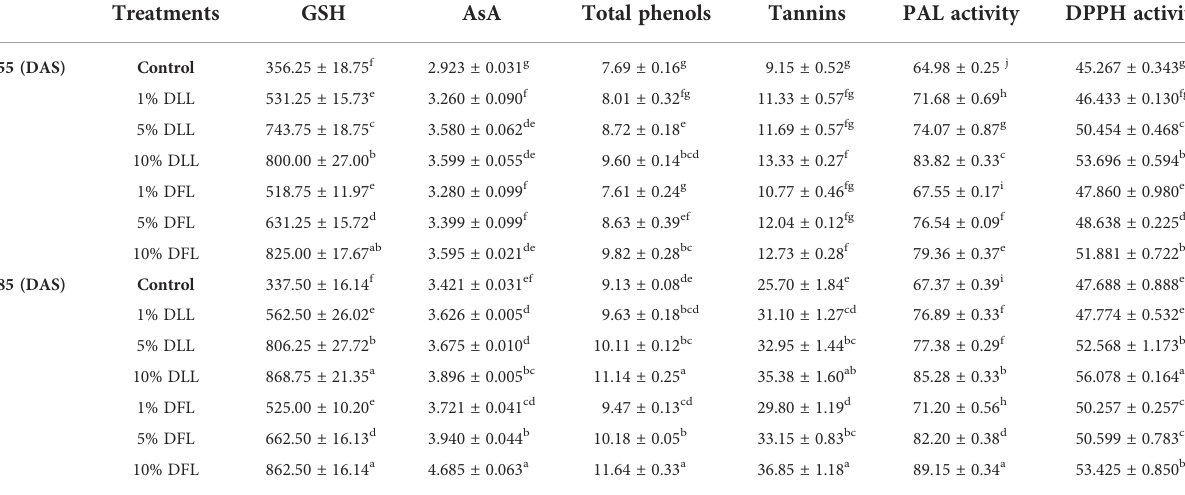
TABLE 4 Reduced glutathione (nM g -1 fr wt), ascorbic acid content (mg g -1 fr wt), total phenols, tannins (mg g -1 dr wt), phenyl alanine ammonia lyase (nM trans-cinnamic acid min -1 mg -1 protein), and total antioxidant (percent) activity in fl ag leaves of Triticum aestivum L. raised using soil substrate at different developmental stages treated with leachates of dry leaves and fl owers of Tagetes erecta